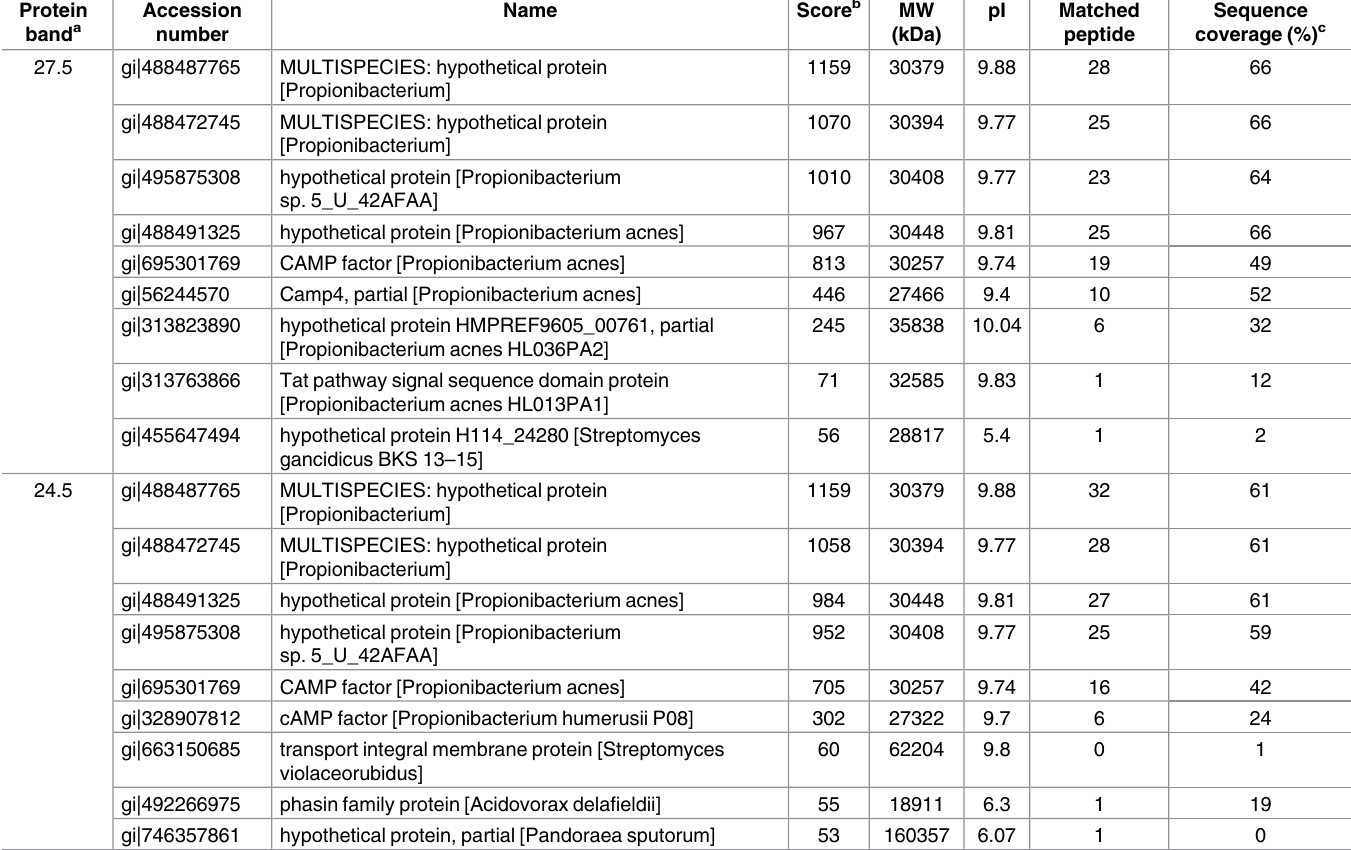
Table 1. Proteins identified by LC-MS/MS in the trypsin-digested fragment from the 24.5- and 27.5-kDa P . acnes protein recognized by TLR-2 Protein band